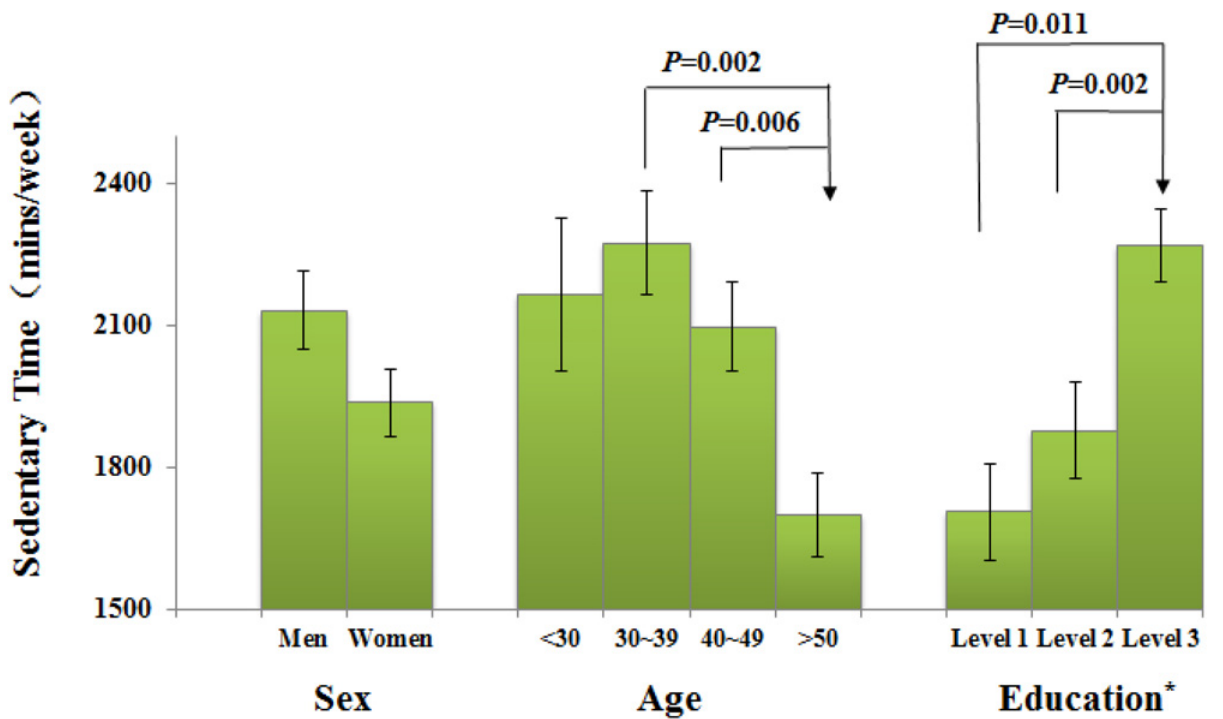
Fig 2. Differences in sedentary time associated with sex, age, and education level. The top line of each closed rectangle represents the adjusted mean, and the vertical bar represents its 95% CI, which was estimated using a multilevel mixed-effects model, after grouping by community. Education * : Level 1, Junior high school or below; Level 2, Senior high school; Level 3, College/university or